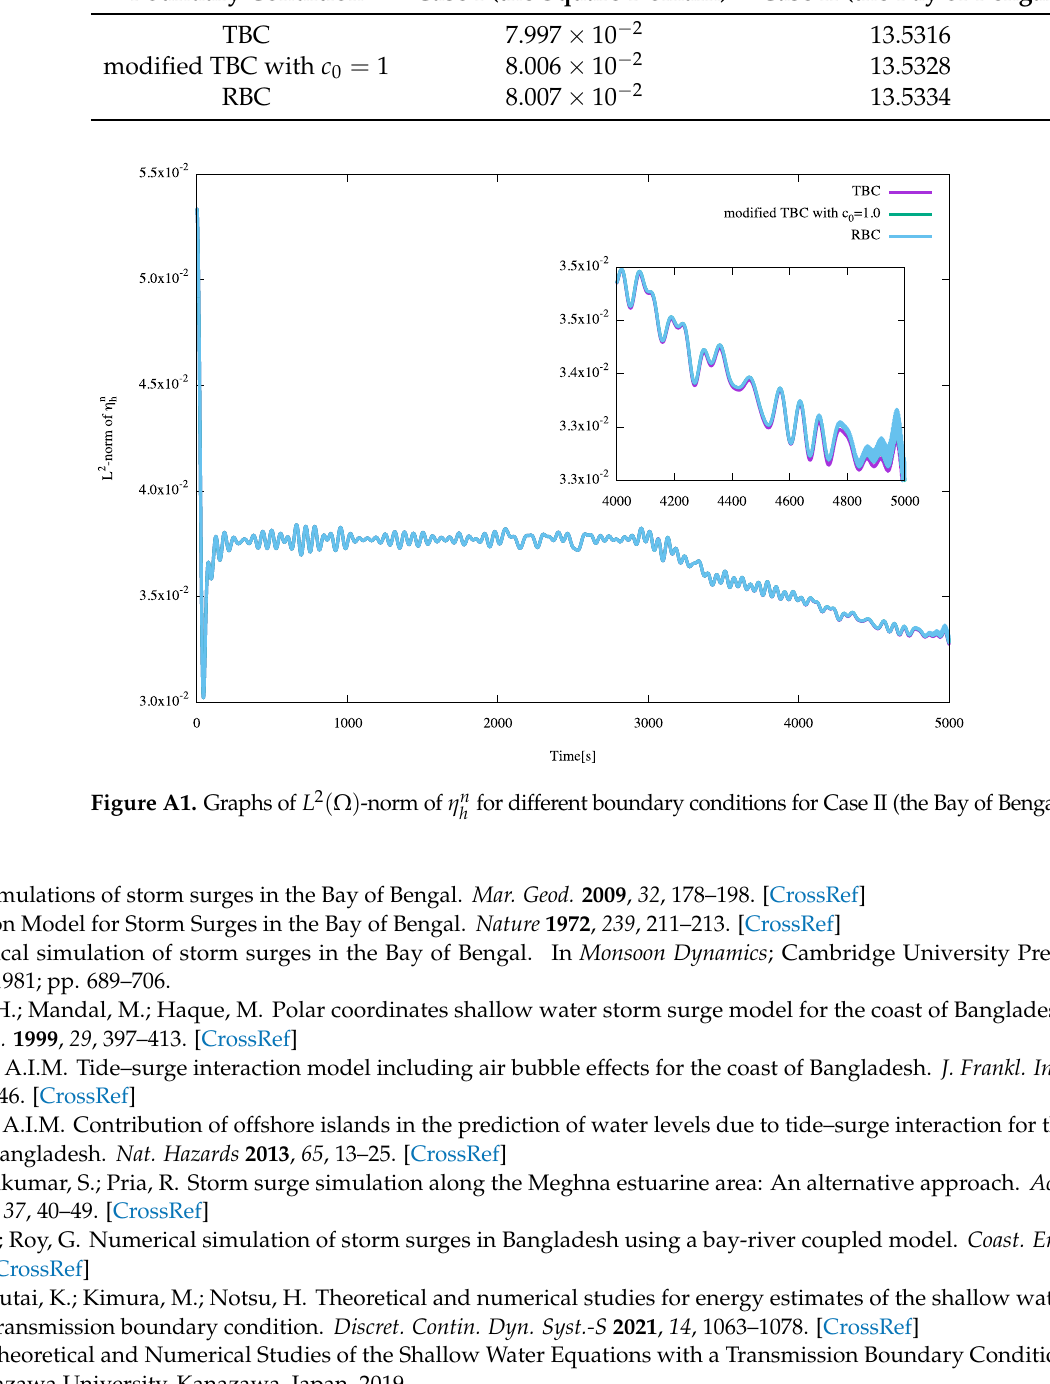
(cid:107) η (cid:107) (cid:96) 2 ( L 2 ) h